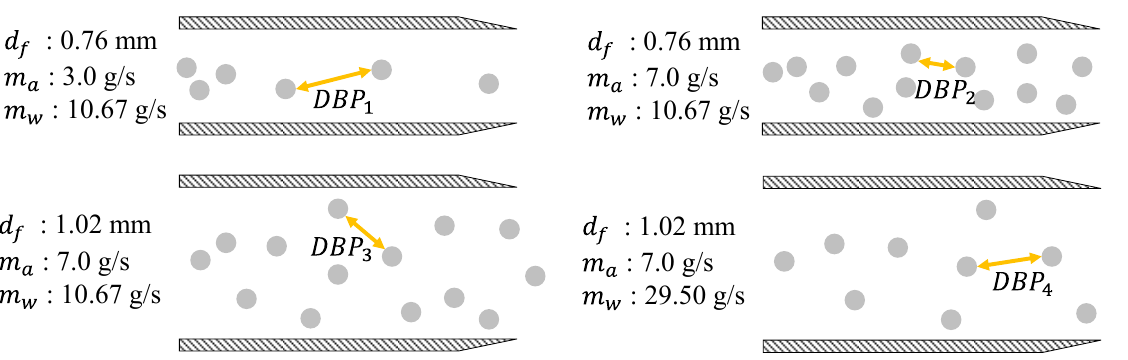
Figure 1. Conceptual illustration of the distance between particles (DBP) in the focus.